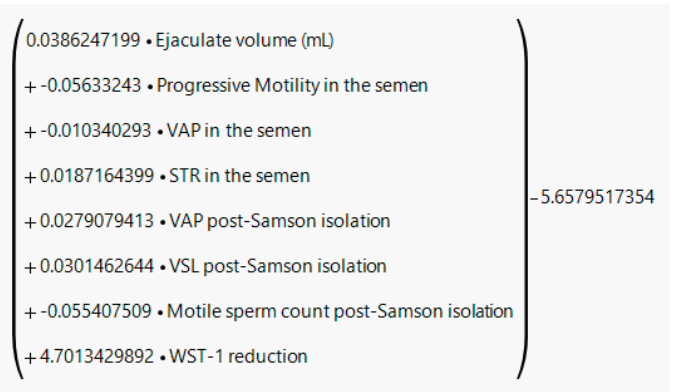
Figure A1. Equation generated when all continuous variables from the pre-chilled data set, were made available from all stallions achieving a predictive accuracy for the whole group of 76.1%.